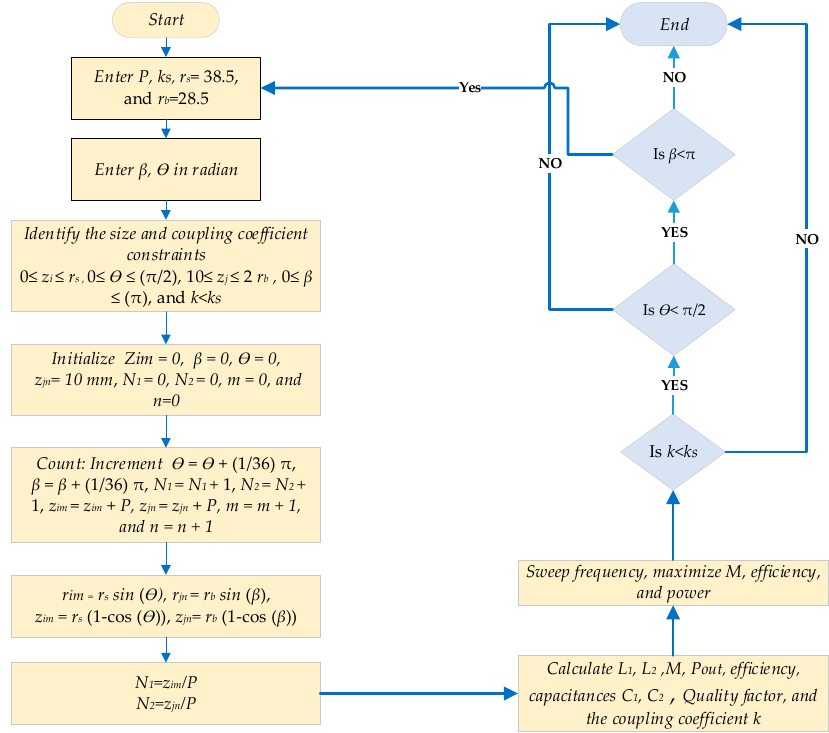
Figure 7. Flowchart representing the algorithm design of the joint WPT.